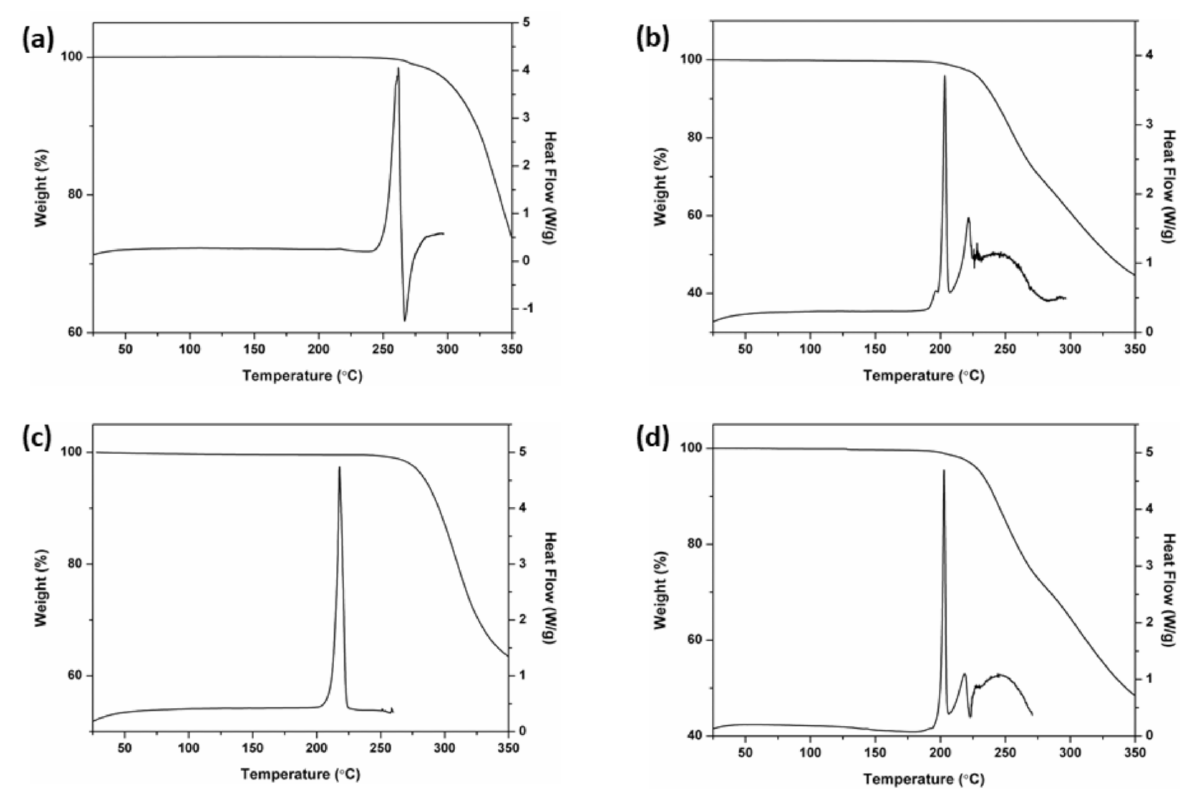
Figure 4. TGA-DSC for the L-Pro (Figure S4), RSV ( a ), RSV-L-Pro ( b ), PD ( c ), and PD-L-Pro ( d